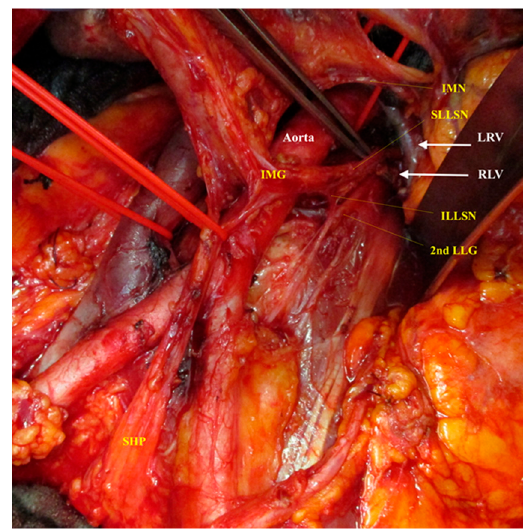
Figure 5. A lateral view of the dissected left cord of the aortic plexus with focusing on the complex anatomy at the origin of superior left lumbar splanchnic nerve. IMN, intermesenteric nerve; SLLSN, superior left lumbar splanchnic nerve; LRV, left renal vein; RLV, renal–lumbar vein; ILLSN, inferior left lumbar splanchnic nerve; 2nd LLG, left lumbar ganglion; IMG, inferior mesenteric ganglion; SHP, superior hypogastric plexus.